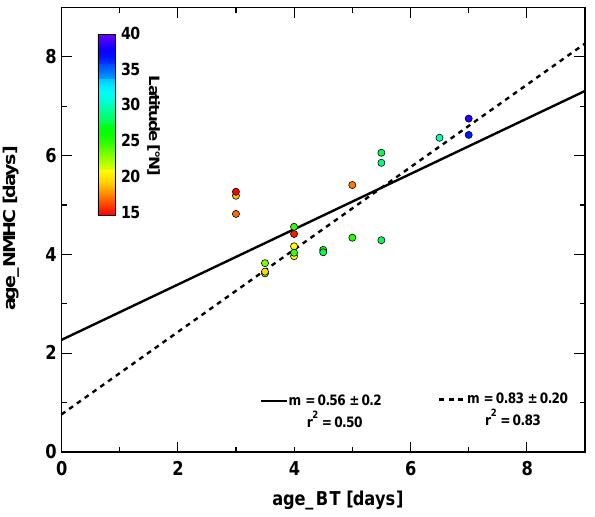
Fig. 10. Relationship between O 3 and n-butane/propane within the monsoon region during July (circles) and August (diamonds). The solid line represents the linear fit the data (for both months) and the uncertainty of the slope represents the 95% confidence interval. Points are color coded by sampling location